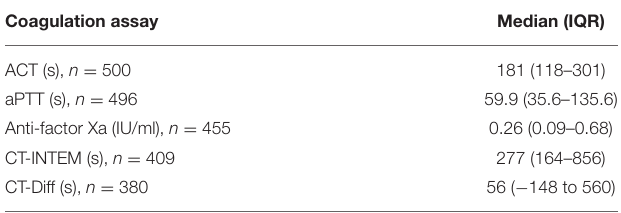
TABLE 1 | Median values of the different coagulation assays.